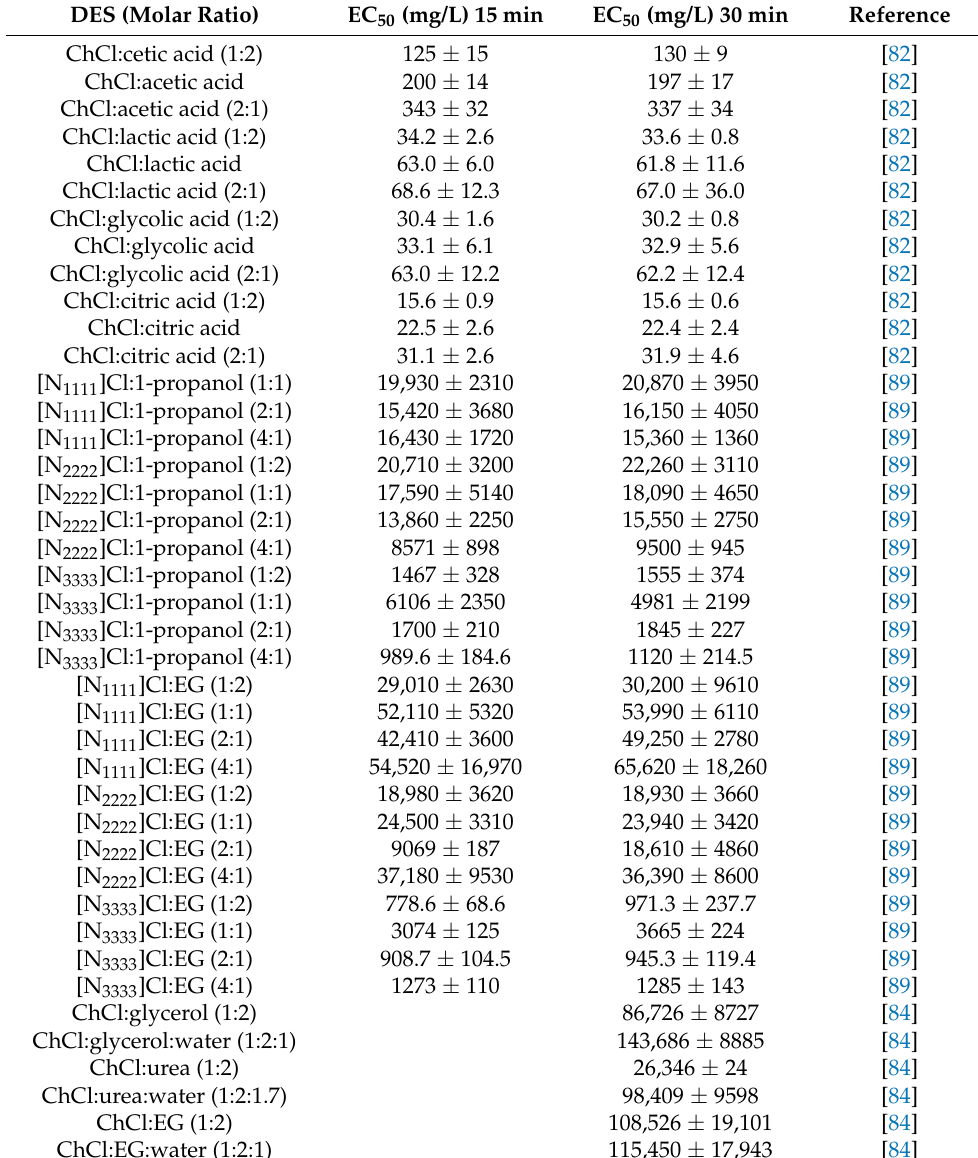
Table 3. Ecotoxicological data of some DESs in A. fischeri